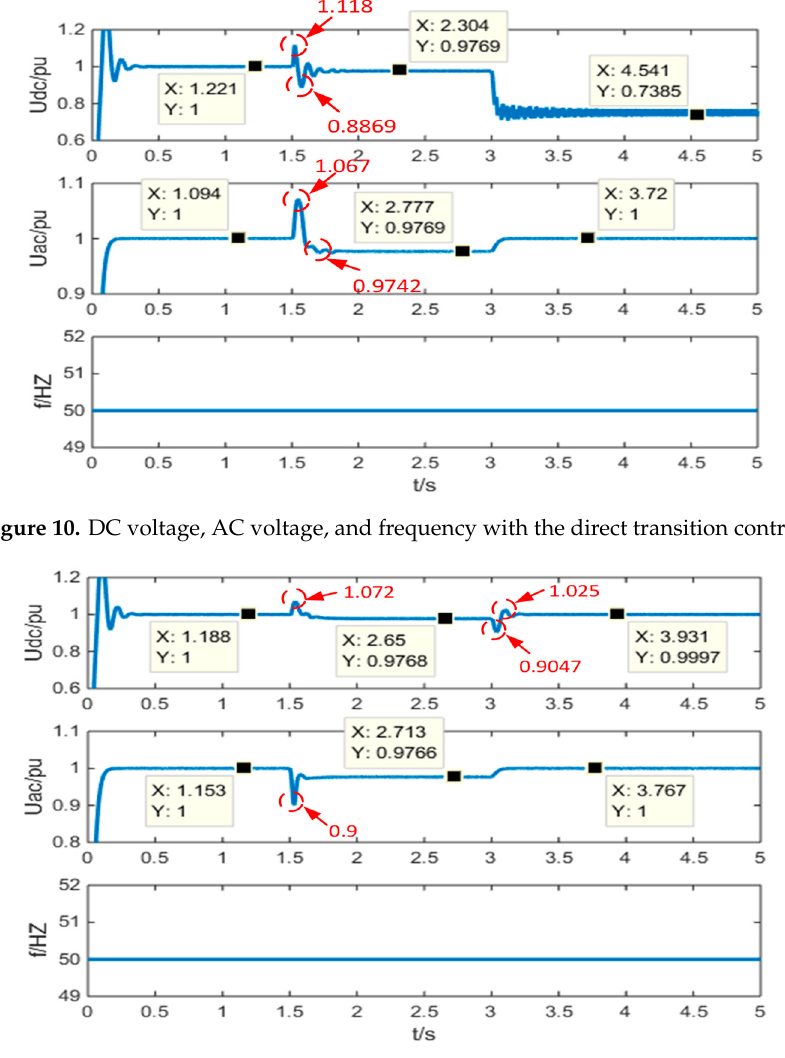
Figure 12. DC voltage, AC voltage, and frequency with islanding signal-based smooth transition control. Table 1. Hybrid micro-grid operating status, from grid-connected mode to islanding mode. Transition Control